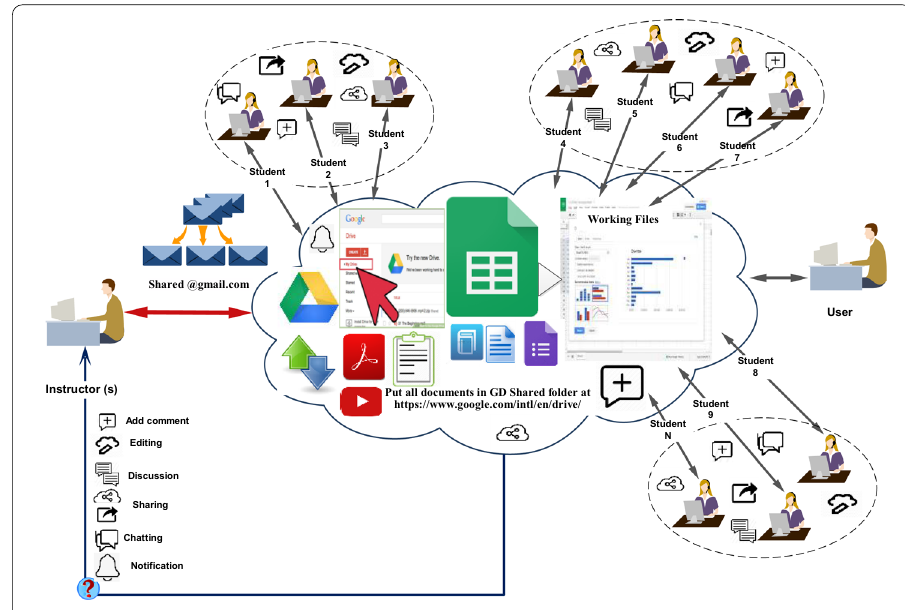
Fig. 2 An illustration of the collaborative learning activity in Google